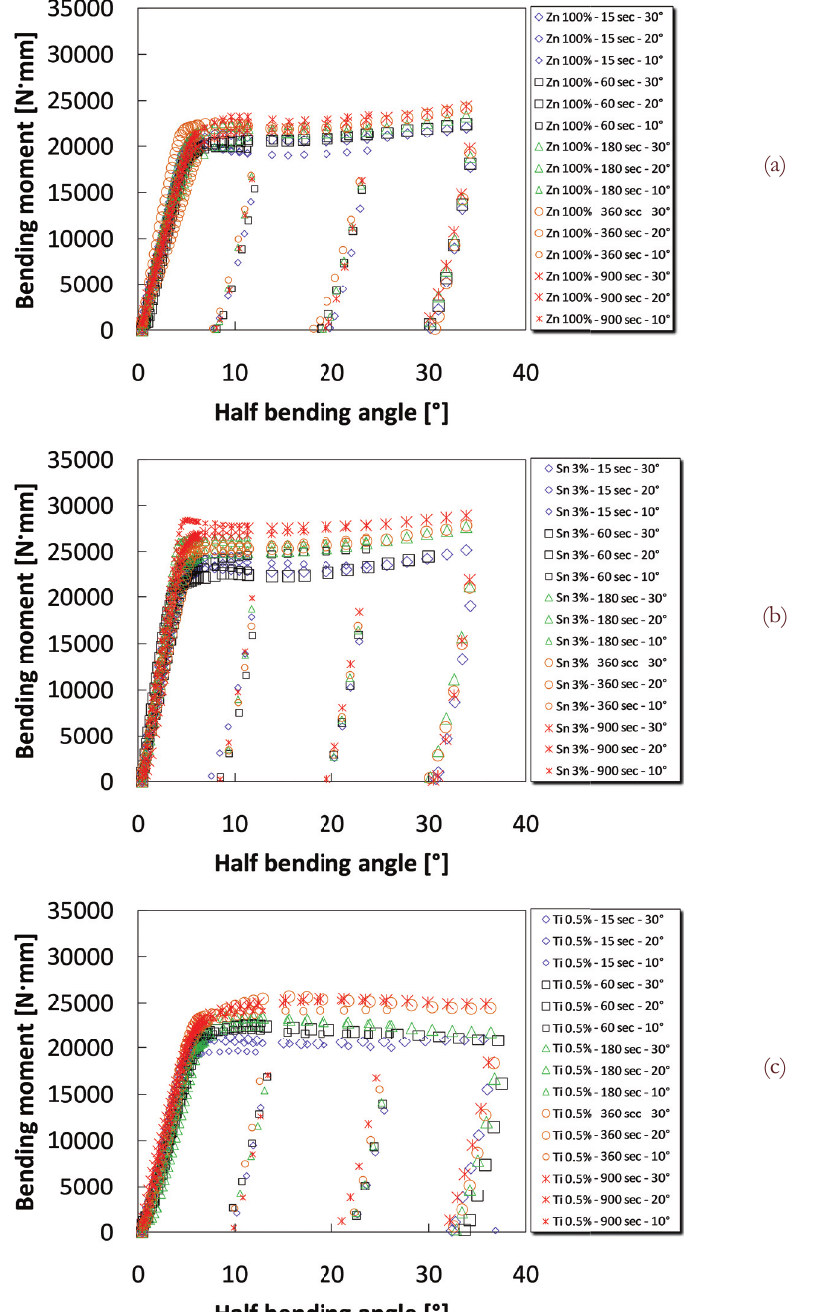
Fig gure 9: Dippin Co onsidering coa pha ases distribut dis tribution is n low wer dipping t cor rresponding